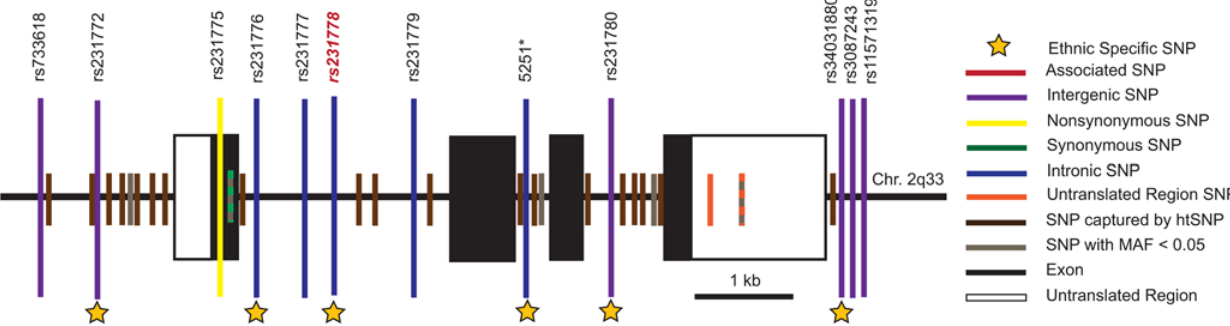
Figure 1. Only SNPs genotyped in this study are listed by name. SNPs in linkage disequilibrium with SNPs genotyped in this study are shown in brown. SNPs in gray were not genotyped or haplotype tagged due to low minor allele frequency (MAF). SNP - Single Nucleotide Polymorphism. 5251* is not yet registered in dbSNP as described in the methods. doi:10.1371/journal.pgen.1000424.g001 PLoS Genetics |